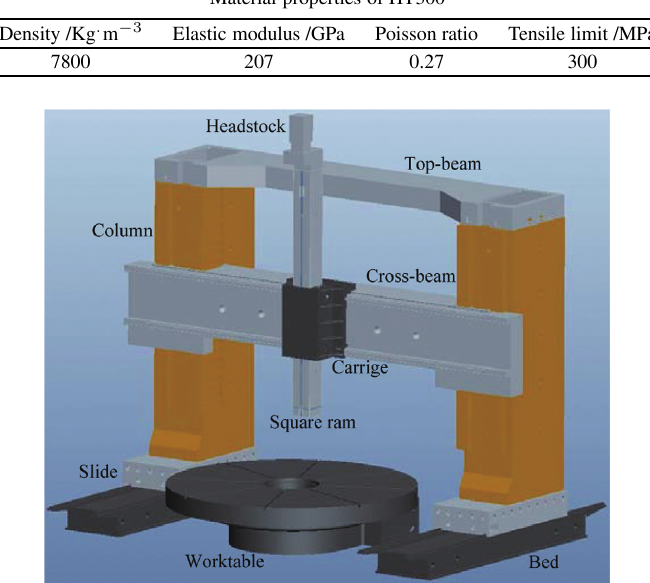
Fig. 3. 3-D model of gantry machining center.